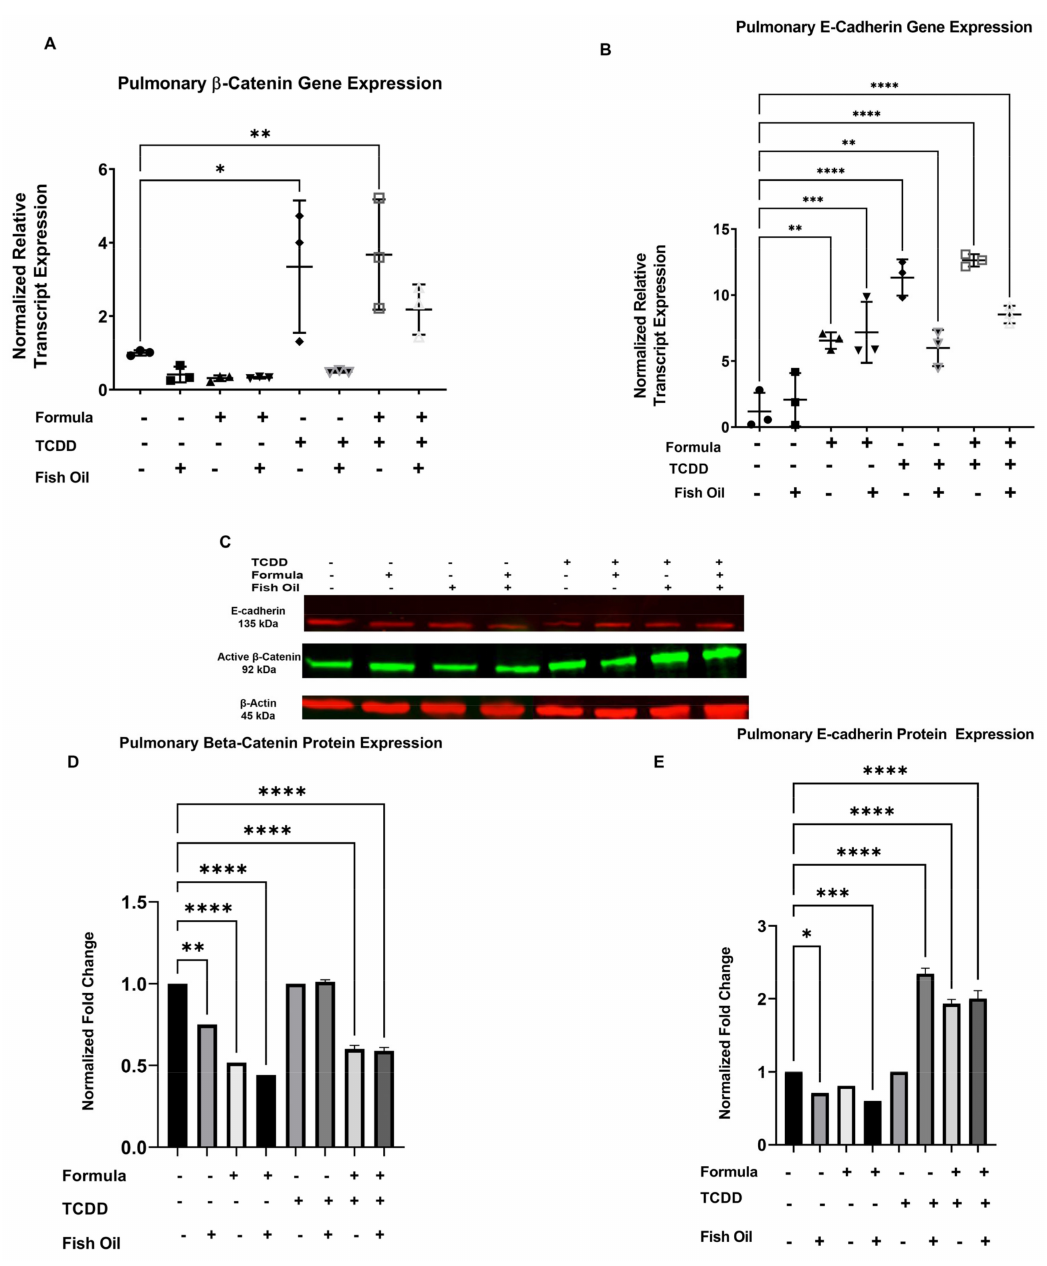
Figure 5. Diet and history of TCDD exposure influence beta-catenin and E-cadherin expression: RNA isolated from the lungs of PND 11 CT and F2TCDD pups ± a fish oil intervention and/or supple- mental formula was used to quantify the expression of beta-catenin and E-cadherin gene expression ( A , B ), beta-catenin and E-cadherin protein expression were measured through immunoblotting ( C ), and quantified using densitometry ( D , E ). * p ≤ 0.05; ** p ≤ 0.01; *** p ≤ 0.001; **** p ≤